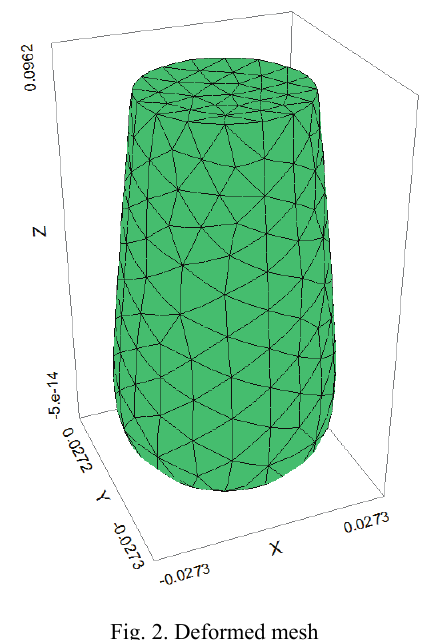
Fig. 3. Point at which the plots were generated